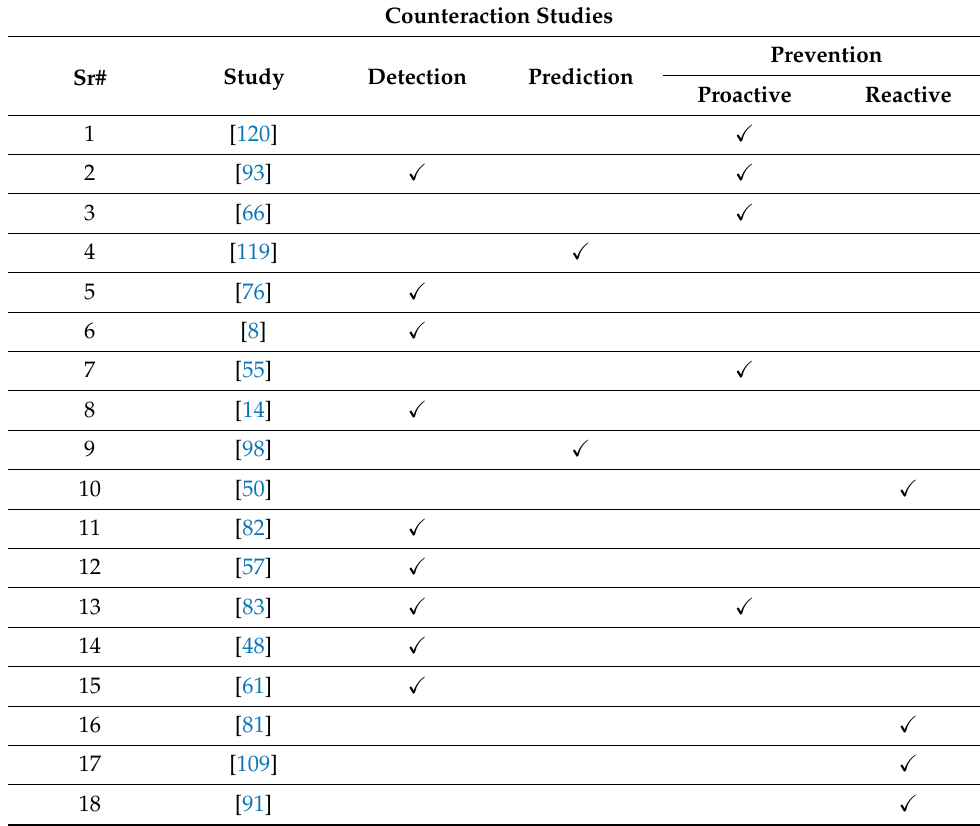
Table 5. Summary of ransomware counteraction